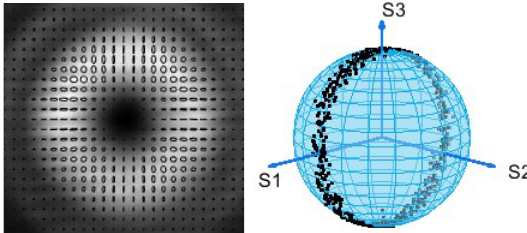
Figure 3 : Polarisation vector distribution in the cross-section of the real Poincaré beam analysed by PSA1. The polarisation vectors/ellipses in the cross-section symbolise linear, right- handed and left-handed polarisation. Polarisation handedness is the same for diagonal quadrants. The polarisation vectors of the beam are depicted on the Poincaré sphere